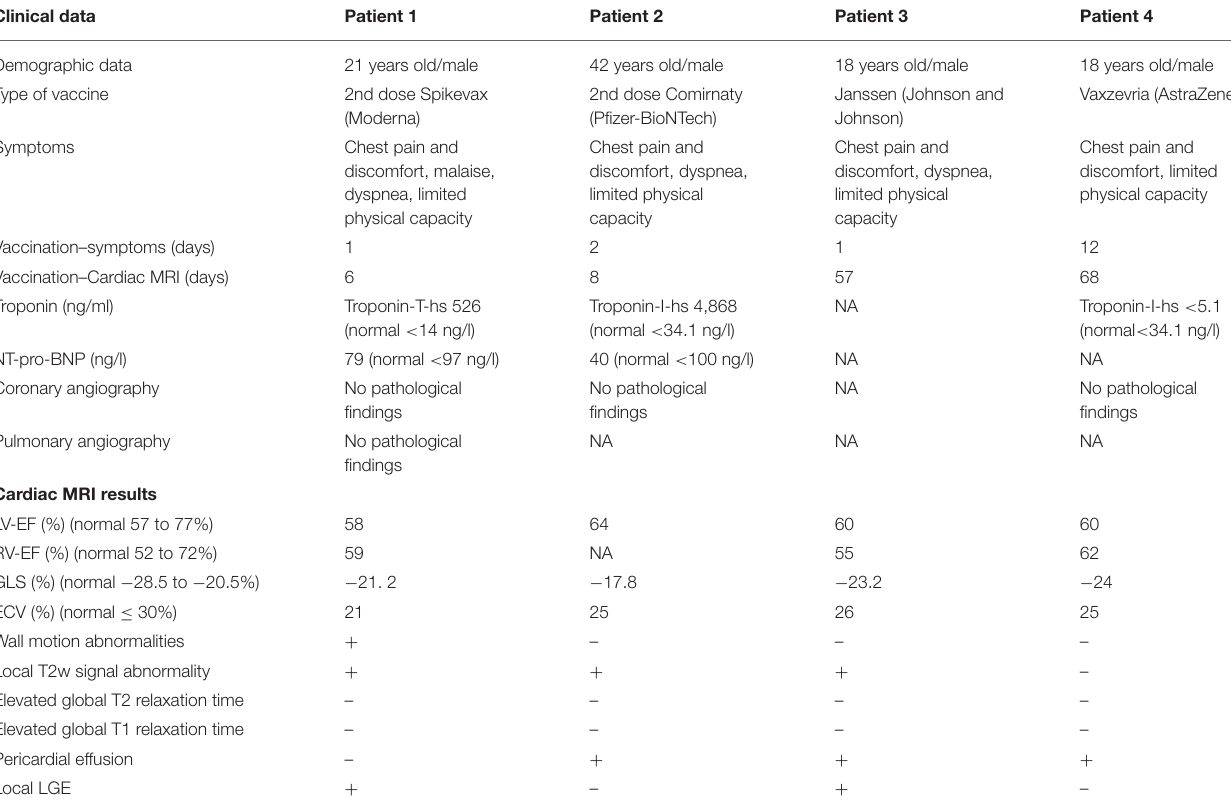
TABLE 1 | Four patients diagnosed with signs of myocarditis/pericarditis in temporal relation to a SARS-CoV-2 vaccination. Clinical